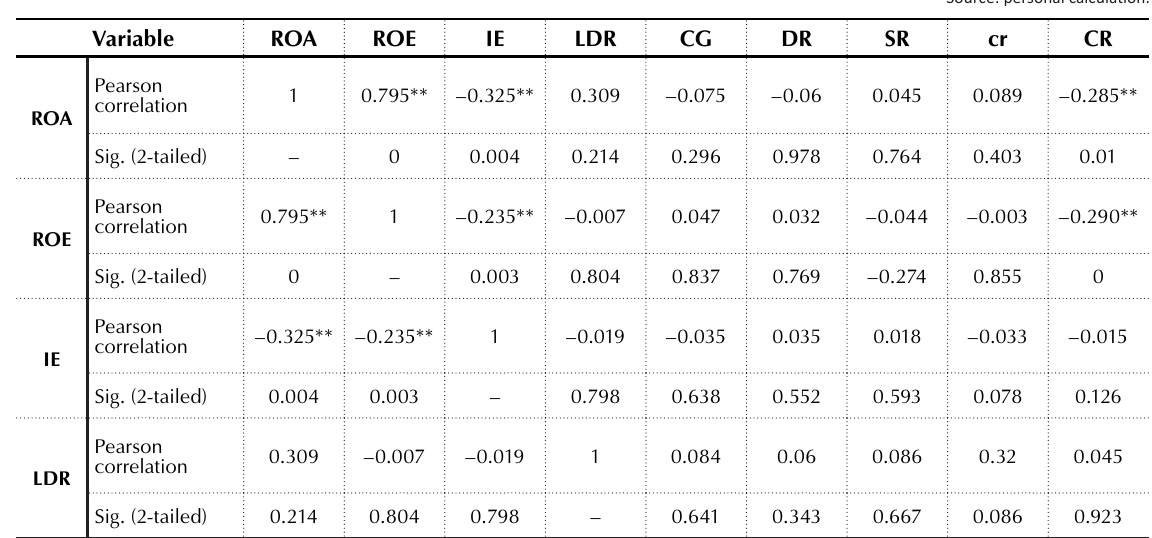
Table 3. Correlation matrix of bank specific